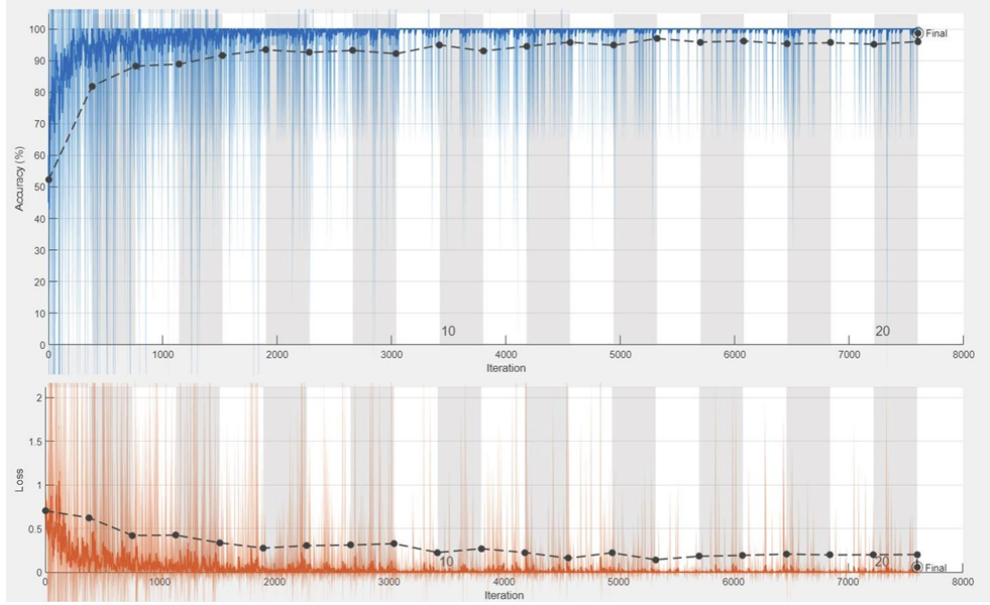
Figure 10. Efficientnetbo train–test performance. The small difference between the training and test loss curves demonstrate that there is no